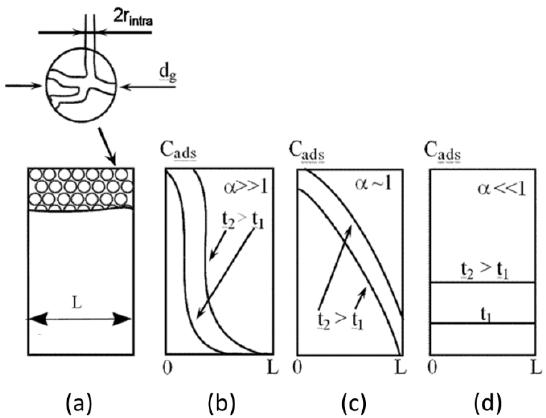
Figure 3. Schematics of the adsorbent bed comprised of the primary grains of size d g ( a ) and the profiles of adsorbed water concentration at adsorption times t 1 and t 2 for various contributions of the inter- and intragrain diffusional resistances ( b – d ). Reprinted/adapted with permission from Ref. [77]. (Copyright 2010), Elsevier.